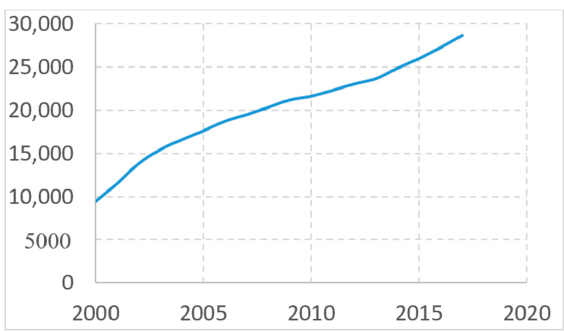
Figure 1. Development of the number of onshore wind turbines in Germany in the years 2000–2017 [5].